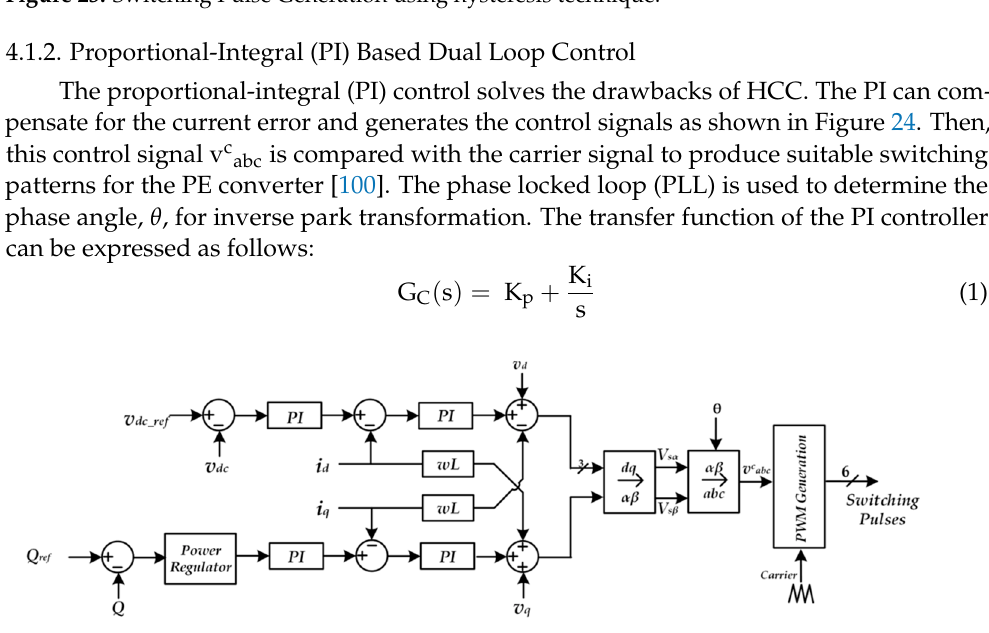
Figure 23. Switching Pulse Generation using hysteresis technique.